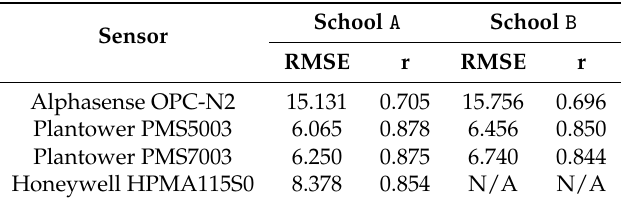
Table 6. Root Mean Square Error (RMSE) and Pearson coefficient (r) of one Air Quality (AQ) Internet of Things (IoT) device at School A and one device at School B , compared against the “Southampton Centre” Automatic Urban and Rural Network (AURN) station [49].